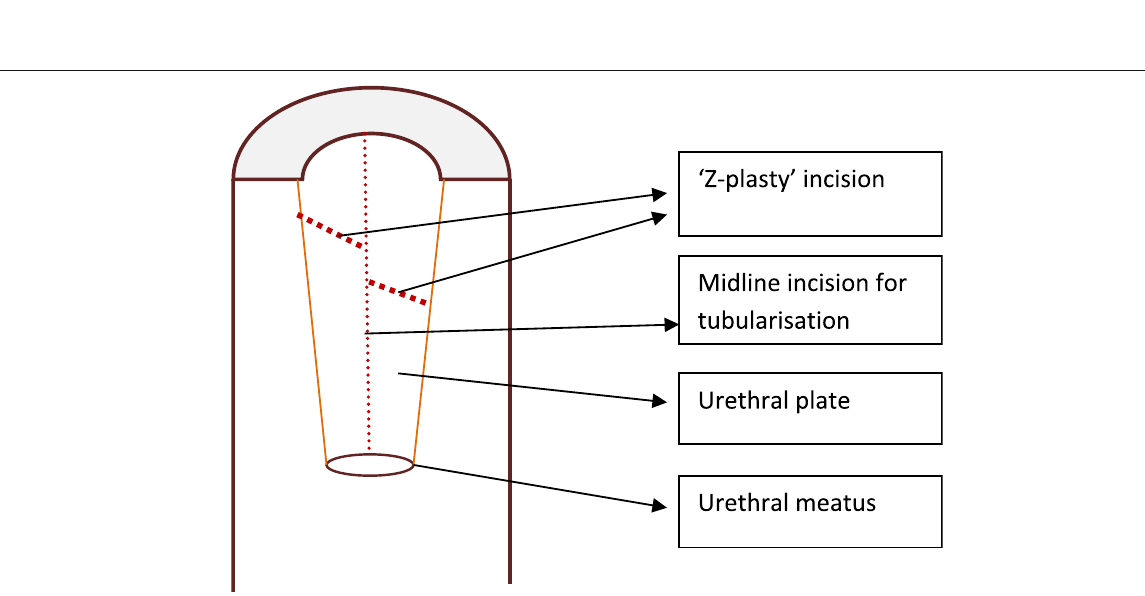
Fig. 4 Schematic representation of the Z-plasty incision, given along with the midline vertical incision, for a short urethral